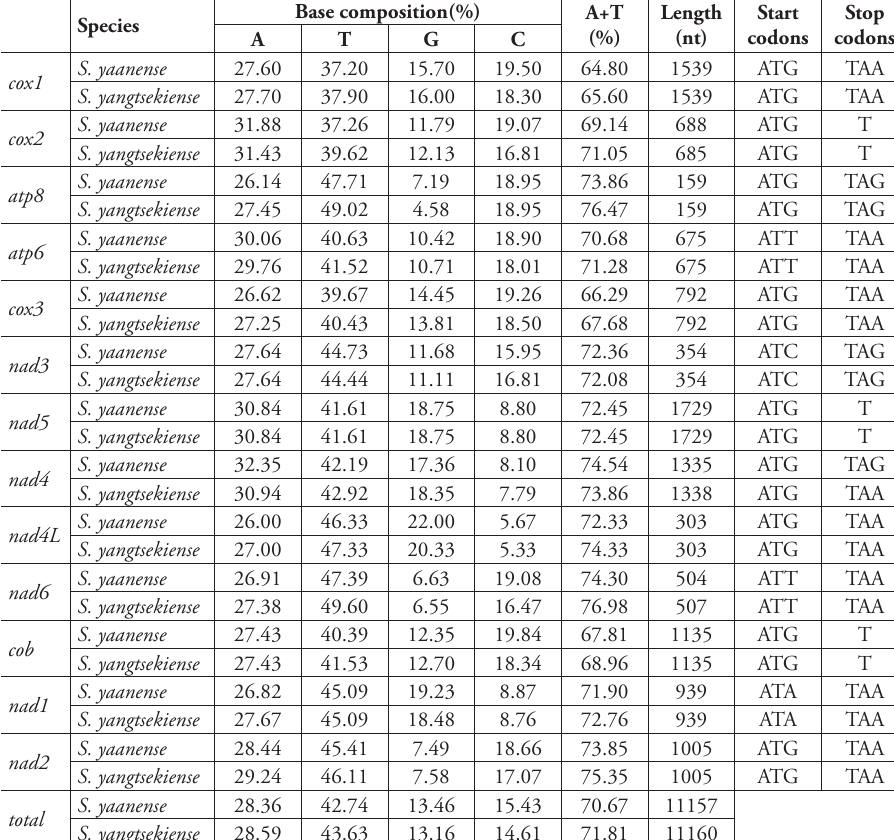
Table 2. Nucleptide composition in 13 PCGs of the Sinopotamon yaanense and S. yangtsekiense mi-